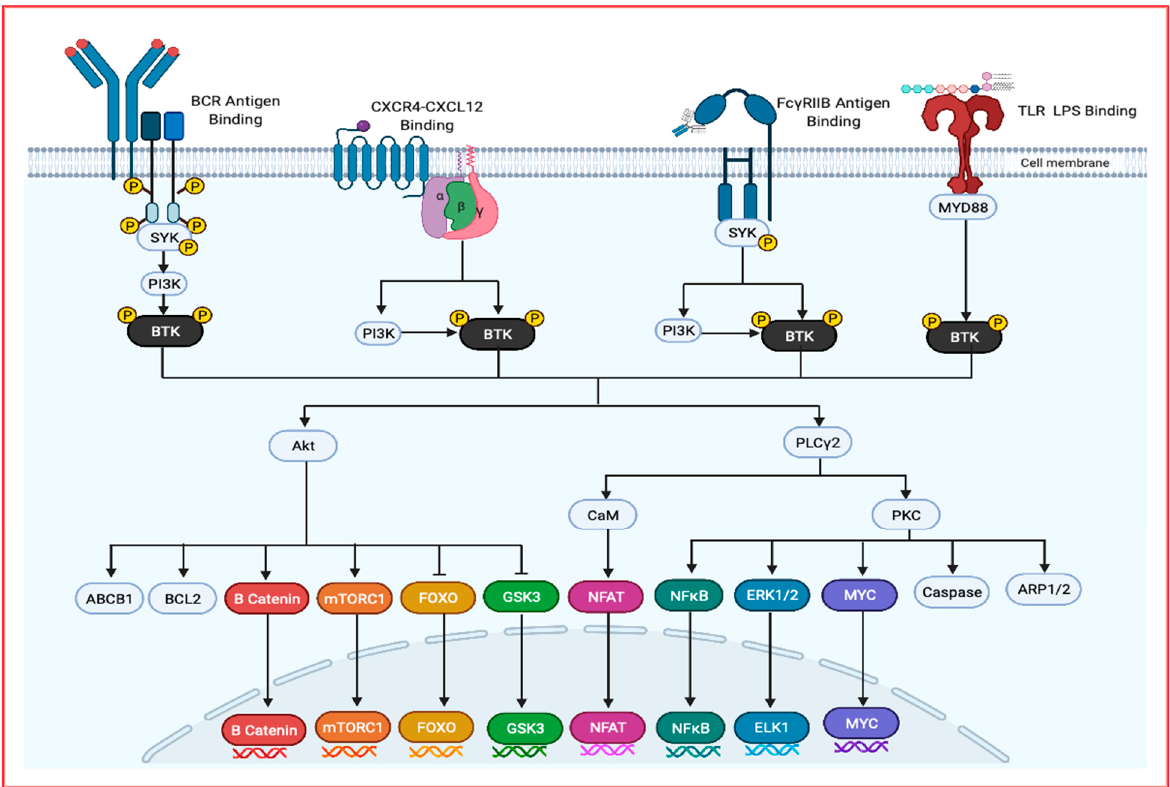
Figure 3. An overview of BTK activators and downstream signaling targets. BTK can be activated through several pathways include BCR signaling, chemokine signaling, Fc receptor signaling and TLR signaling. Following BTK integration to the cell membrane through its PH domain interaction with PIP3, the phosphorylated protein becomes cytosolic. These signaling pathways lead to the activation of AKT, PLCy2 and a protein complex including BTK, IRAK(1,2,4) and more leading to the downstream transcription factors that promote cancer growth, survival, stemness and migration.